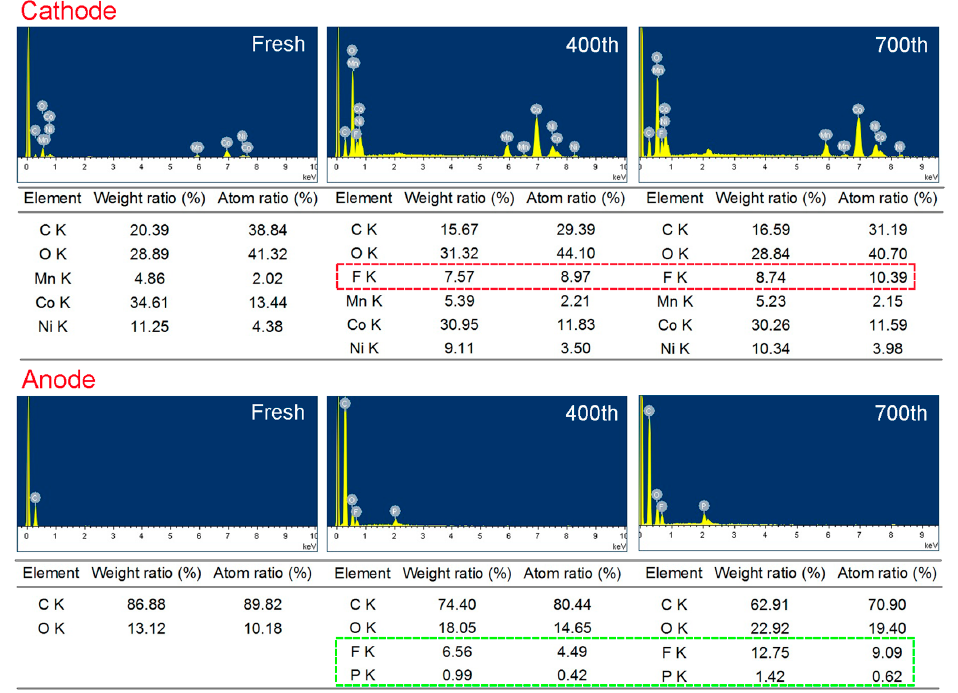
Figure 9. X-ray spectroscopy (EDX) results of harvested LCO + NCM532 cathode electrodes and Gr anode electrodes after experienced various cycles.